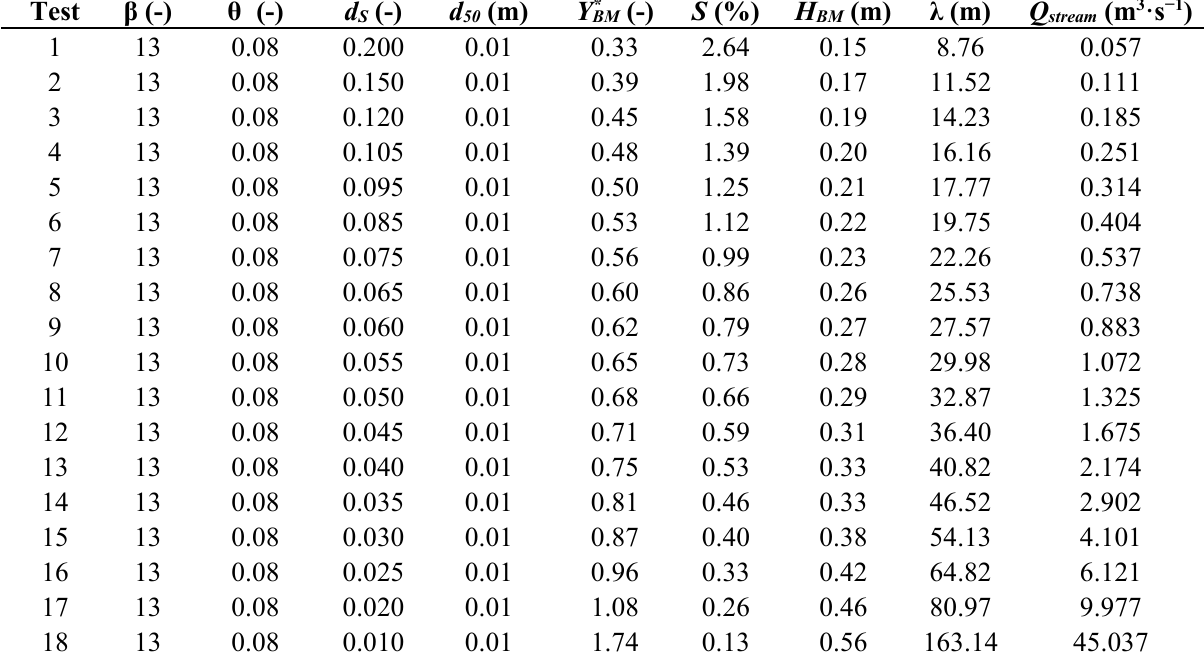
Table 1. Morphodynamic parameters of the pool-riffle bedform. β is the aspect ratio ( β = b/Y 0 ); θ is the Shields’ number; d s is the relative submergence of the particles; d 50 is the median grain size; Y * BM is the dimensionless mean flow depth; s is the streambed slope; ∆ is the bar amplitude; λ is the bar length; and Q stream is the stream water